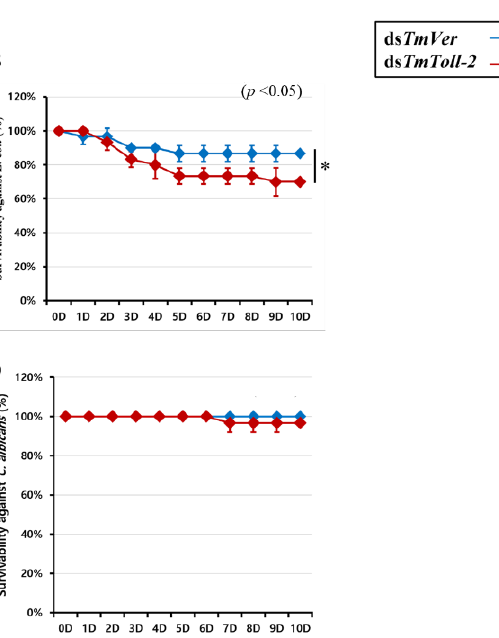
Figure 4. Effect of TmToll-2 gene silencing on T. molitor larval survival. The RNAi efficiency of ds TmToll-2 RNAi was measured by qRT-PCR 4 days after injection ( A ). TmToll-2 -silenced larvae were injected with E. coli ( B ), S. aureus ( C ), and C. albicans ( D ), and survival rates were studied for 10 days post-pathogen injection (n = 10 per group). Larval survival rates at 10 days post-microbial injection were 80% after E. coli injection and 100% after S. aureus and C. albicans injection compared with the levels in the ds TmVer -injected control group. Data were reported as averages of three biologically independent replicates. Asterisks indicate significant differences between ds TmToll-2 - and ds TmVer RNAi-injected groups. Survival analysis was performed using Kaplan–Meier plots (log-rank chi-squared test; * p < 0.05).